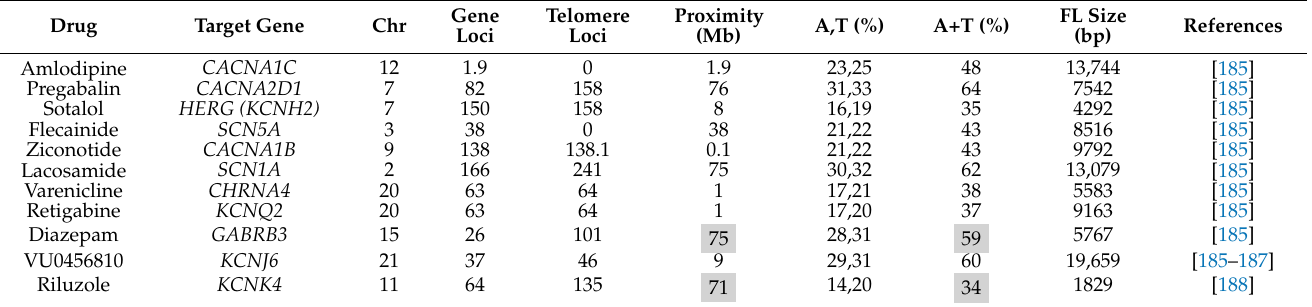
Table 1. Two factor characteristics of 11 ion channels targeted by approved drugs.